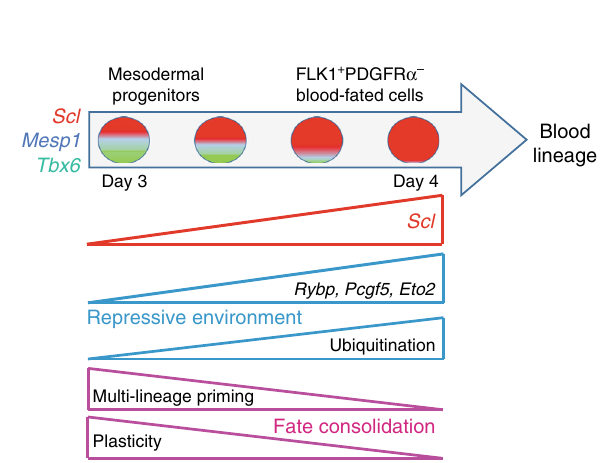
Fig. 8 Model of SCL ’ s functions in blood lineage speci fi cation. Single mesodermal cells co-express blood ( Scl ), cardiac ( Mesp1 ) and paraxial ( Tbx6 )-af fi liated transcriptional regulators at low levels, establishing multi- lineage priming and cellular plasticity. As differentiation progresses, Scl levels increase in FLK1 + PDGFR α – cells. SCL establishes a global repressive environment by activating potent transcriptional repressors ( Rybp / Pcgf5 / E to2) and ensuring genome-wide, high H2AK119Ub levels. This leads to decreased Mesp1 and Tbx6 levels and repression of alternative fates.